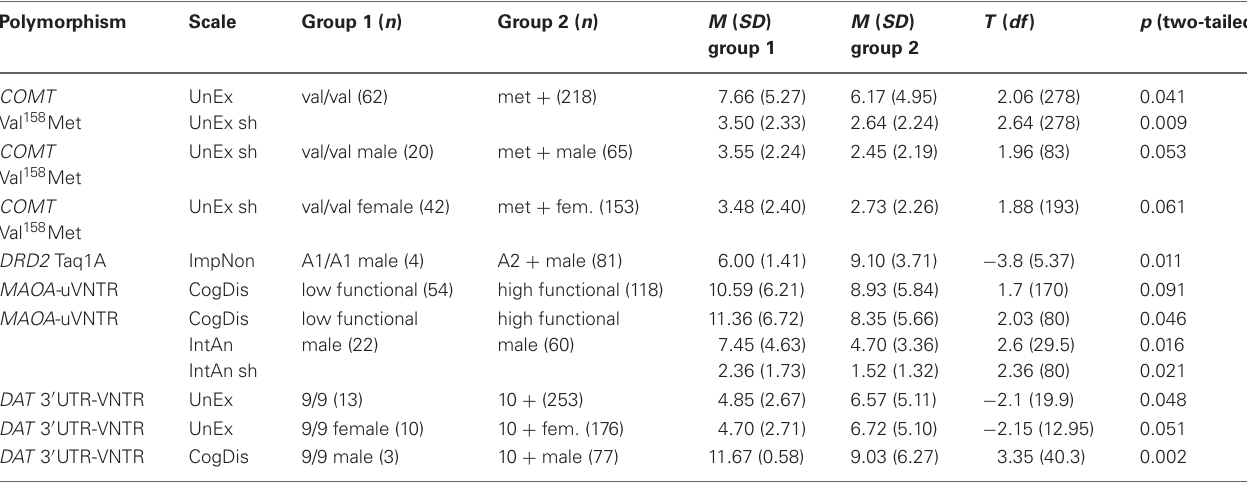
Table 6 | Significant ( p < 0 . 05) genetic associations and borderline-significant trends for O-LIFE-scales. Polymorphism